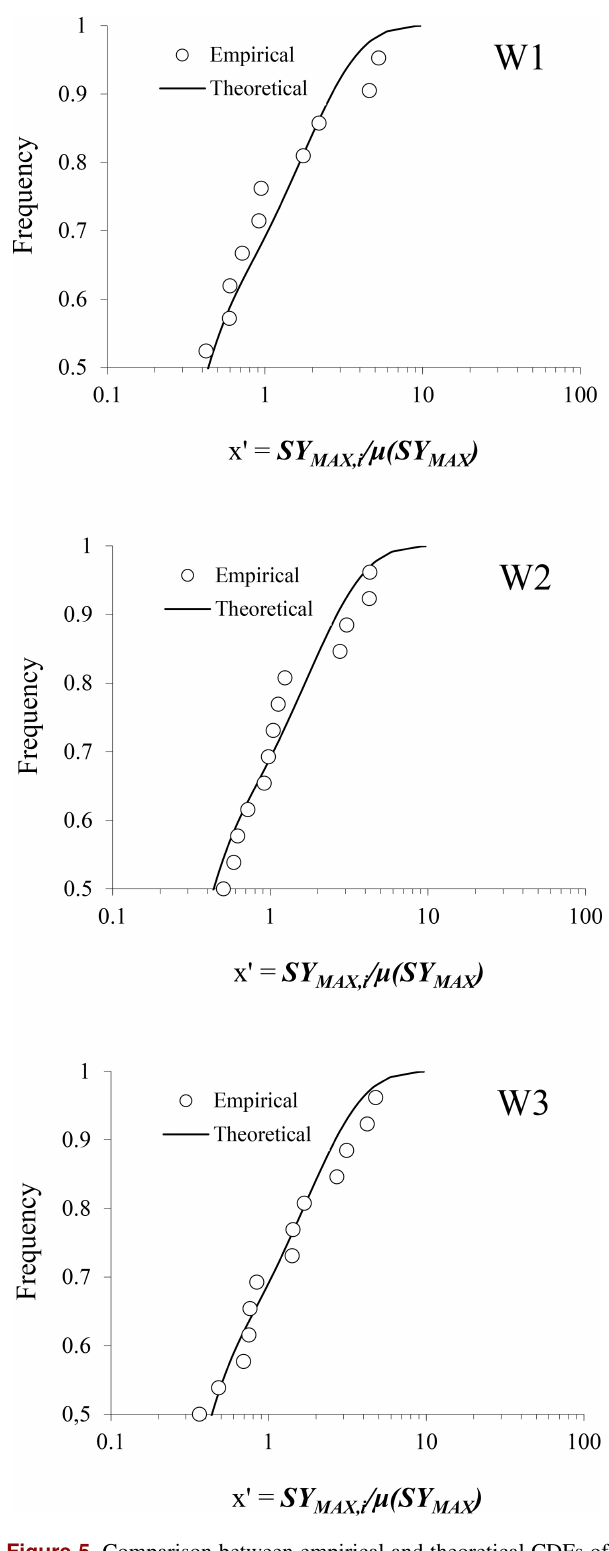
Figure 5. Comparison between empirical and theoretical CDFs of the variable x (cid:48) for the 3 independent datasets (W1, W2 and